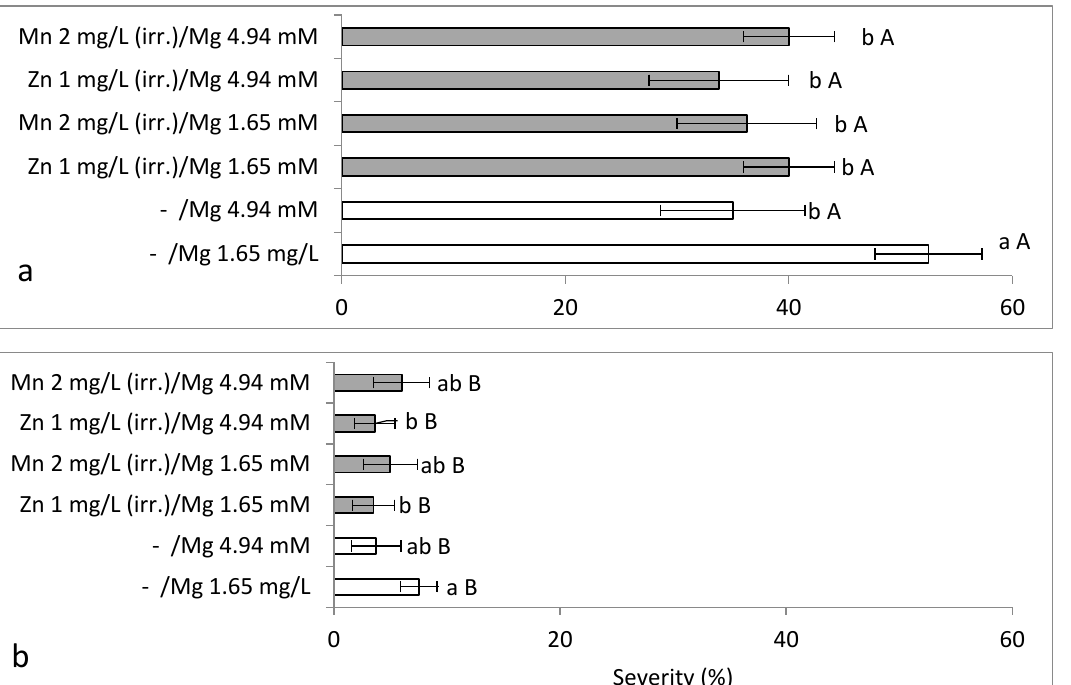
different according to one- way ANOVA with Tukey’s HSD test. The default significance level was set at p ≤ 0.05. nm — of fertigation-applied microelements and fungicides treatments did not have any synergistic not measured. DW — dry weight.